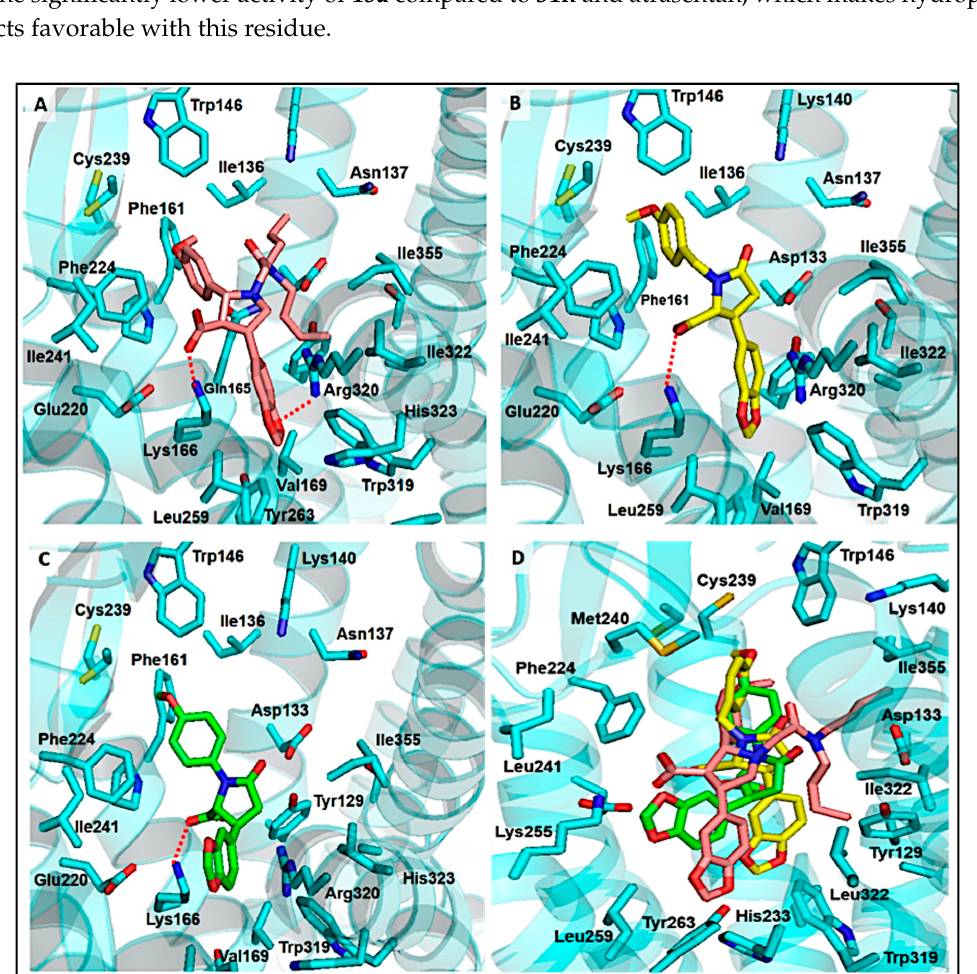
Figure 4. The proposed binding mode of atrasentan ( A ), 31h ( B ), 15a ( C ), and the overlapping ligands ( D ) within the binding site of the ET A R homology model. Ligands are shown as pink, yellow, and green sticks, respectively. Protein is shown as a cyan cartoon with residues within 5 Å of the ligand displayed as sticks. All hydrogen is hidden for clarity. Polar contacts are shown as red dotted lines.